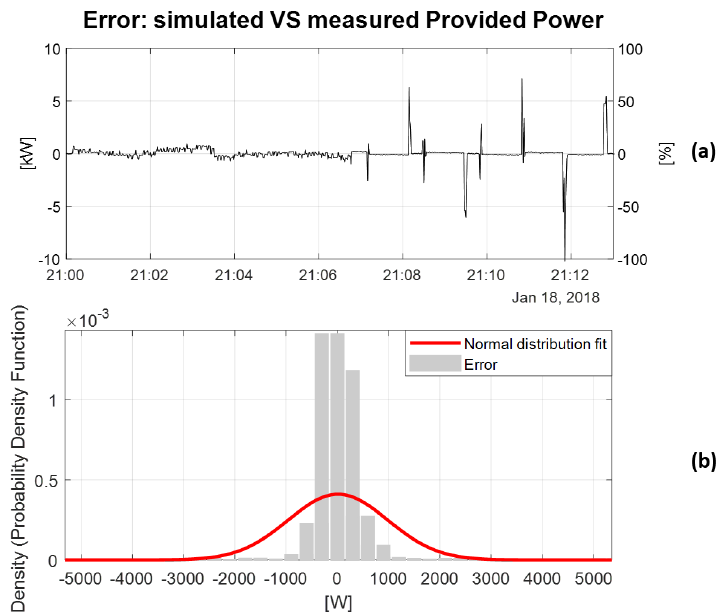
Figure 13. Analyses of the error between the simulated results and the real remote control test results: calculated error for 1 cycle in [kW] and in percentage with reference to the 10 kW size of the charger ( a ), and statistical results for the entire test pattern ( b